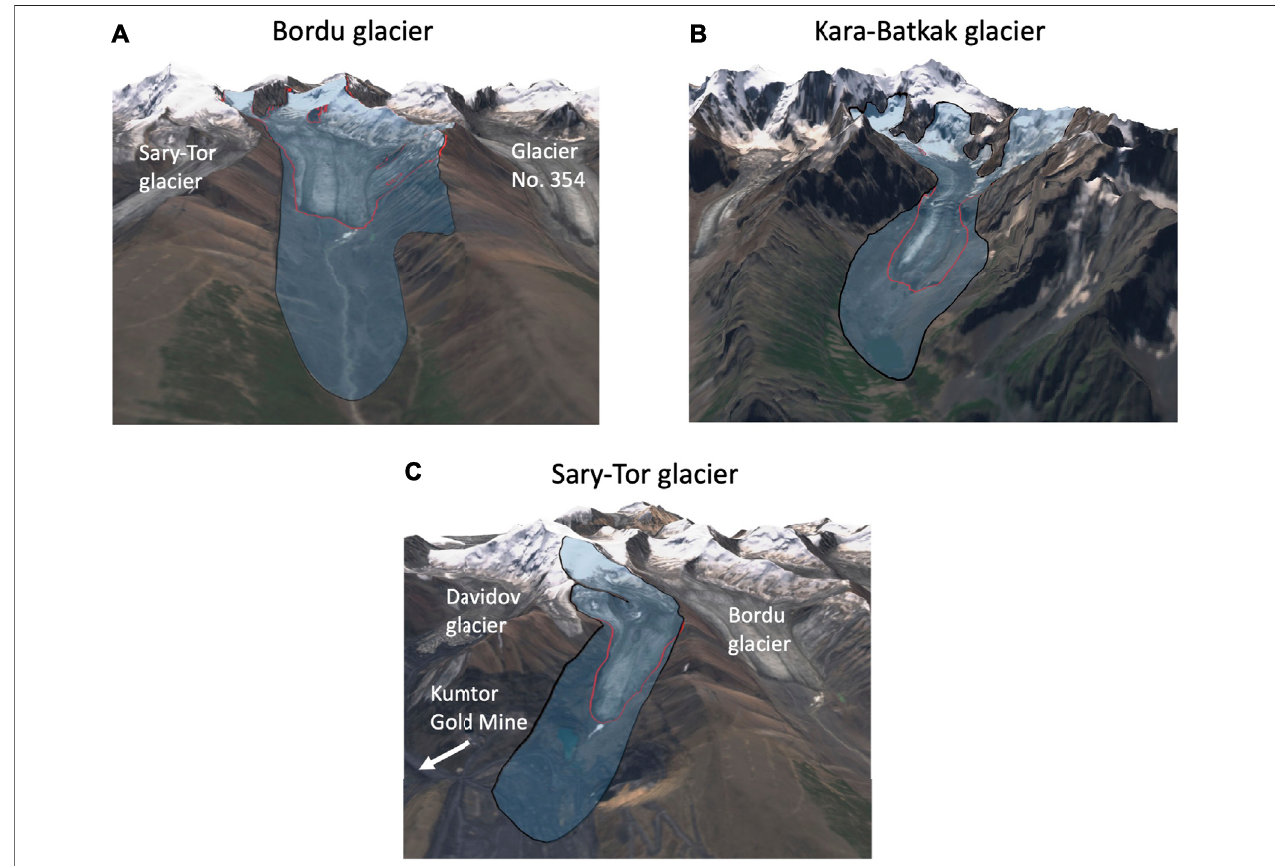
FIGURE 7 | LIA glacier surfaces of the three studied glaciers (blue colour). The present-day glacier outline is indicated in red. The LIA outline is indicated in black.